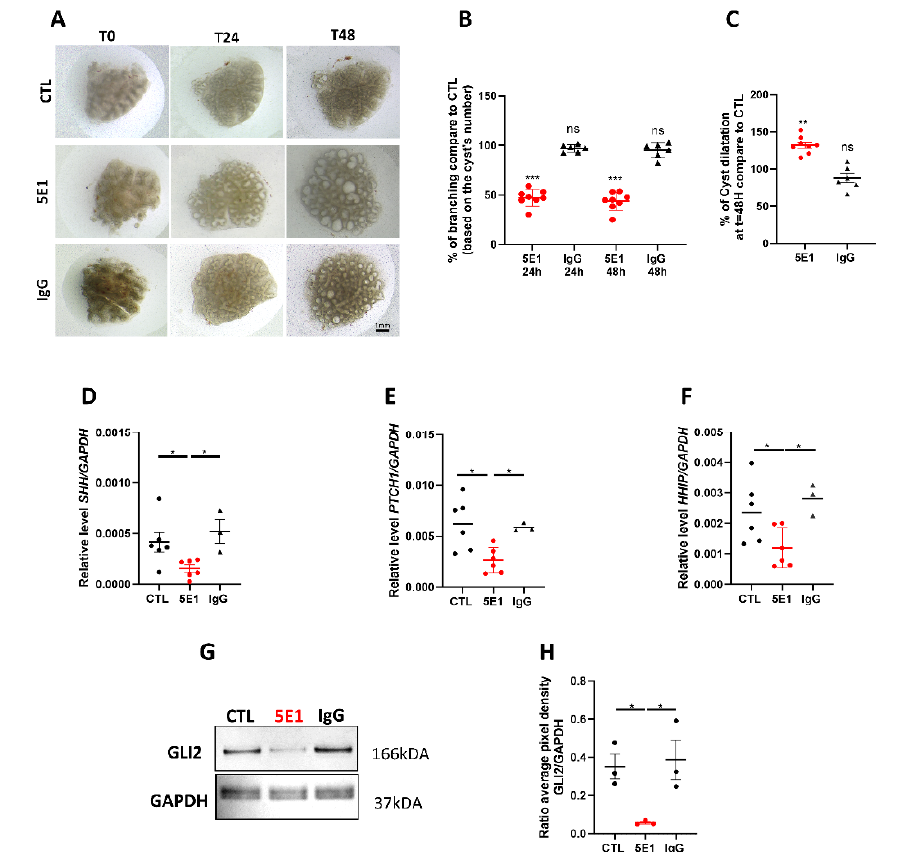
Figure 2. The Hedgehog pathway is required for human lung branching morphogenesis. ( A ) Human fetal lung explant cultures at t = 0, t = 24 h and t = 48 h untreated (in media alone); or treated with 5 µ g/mL IgG as negative control or 5 µ g/mL 5E1. ( B , C ) Graphs showing the percentage of distal branching ( B ) and cyst dilation ( C ) of 5E1, and IgG treated explants as compared to untreated control (CTL) at t = 24 h and t = 48 h. Results are shown in dots and mean ± SEM ( n = 8 for control and 5E1, n = 6 for IgG). ( D – F ) RT-qPCR for SHH ( D ), PTCH1 ( E ), and HHIP ( F ) performed on control ( n = 6), 5E1- ( n = 6; red dots) and IgG- treated explants ( n = 3). Results are shown as individual data points and mean ± SEM. ( G ) Representative western blots for GLI2 and GAPDH in human fetal lung explants treated or not with 5E1 or IgG (5 µ g/mL) for 48 h. ( H ) Dot plots (mean ± SEM) of western blot densitometry ratios for GLI2 normalized to GAPDH ( n = 3 for each condition). * p < 0.05, ** p < 0.01; *** p < 0.001; ns = no